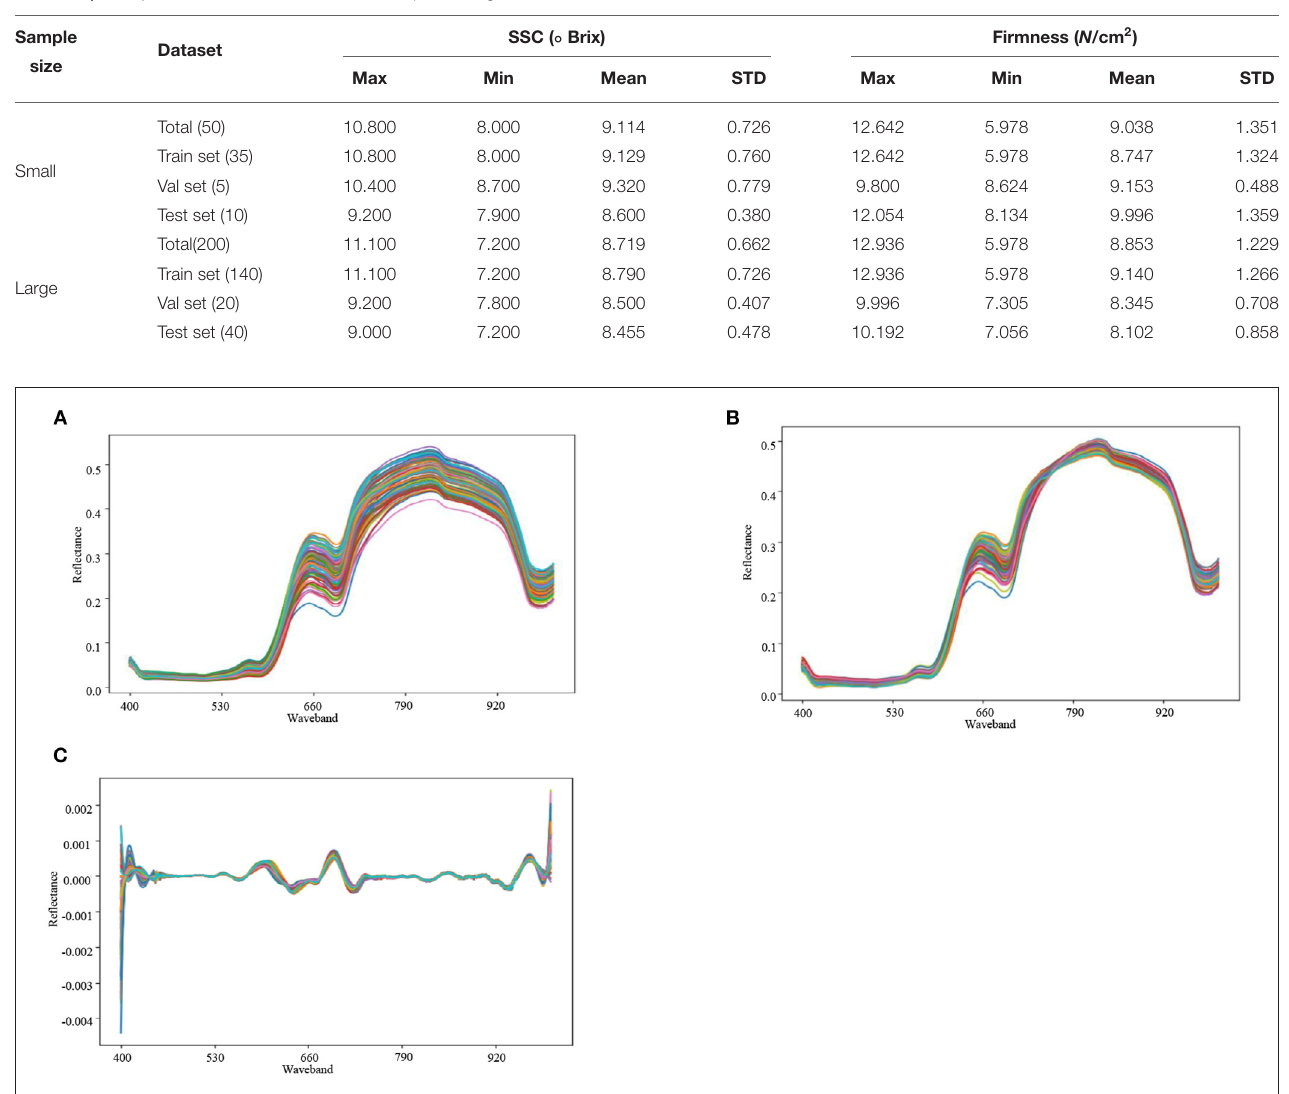
TABLE 2 | Cherry tomato SSC and firmness dataset partitioning.